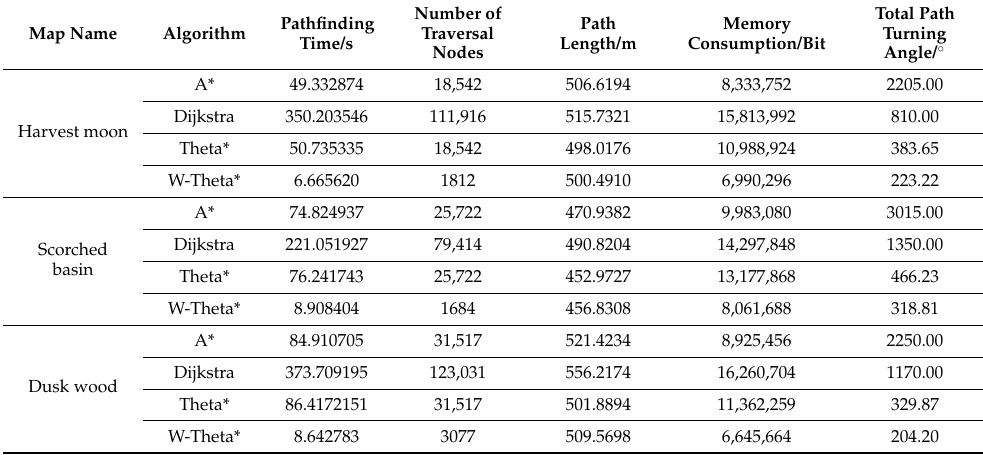
Table 5. Experimental data sheet for various algorithms on Warcaft III